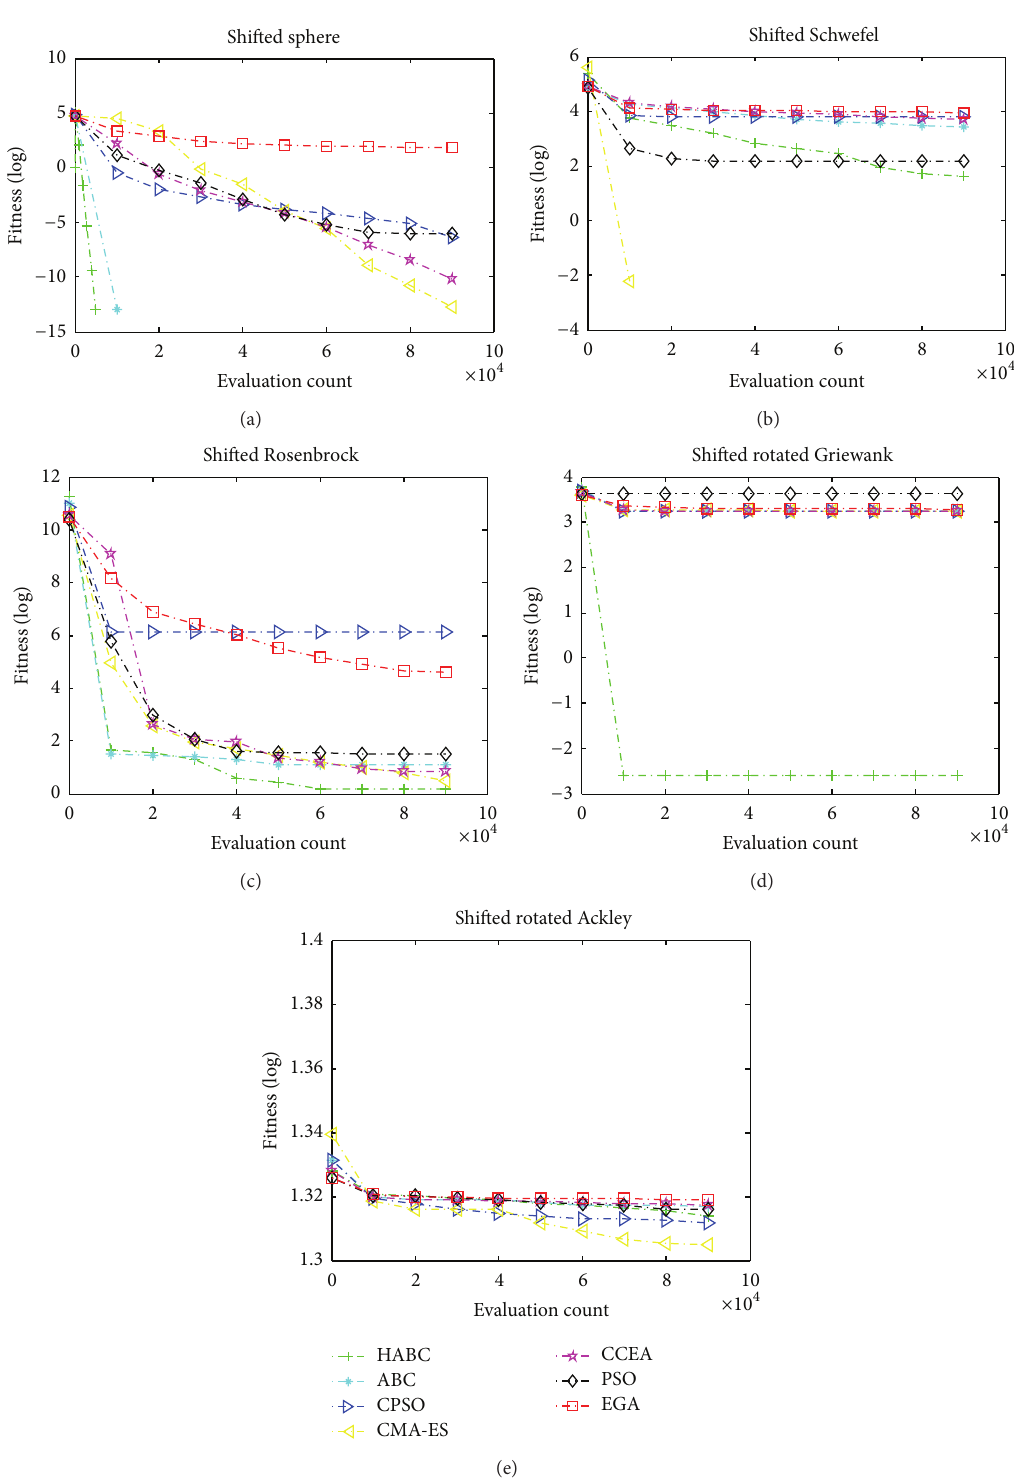
Figure 6: The median convergence results on 100𝐷 CEC functions. (a) Shifted sphere function; (b) shifted Schwefel’s function; (c) shifted Rosenbrock’s function; (d) shifted rotated Griewank’s function; (e) shifted rotated Ackley’s